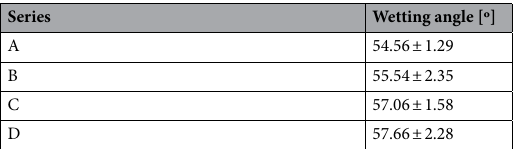
Table 1. The average values with a standard deviation of the contact angle of the sintered Ti6Al4V alloy composites with and without biogenic filler. Series: A—0%, B—1%, C—5%, D—10%.